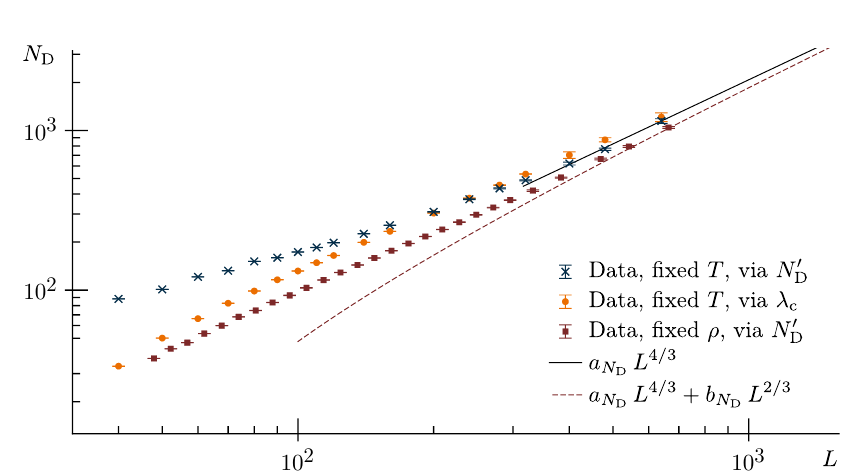
at the finite-size transition point for fixed D and b were determined from N D N D